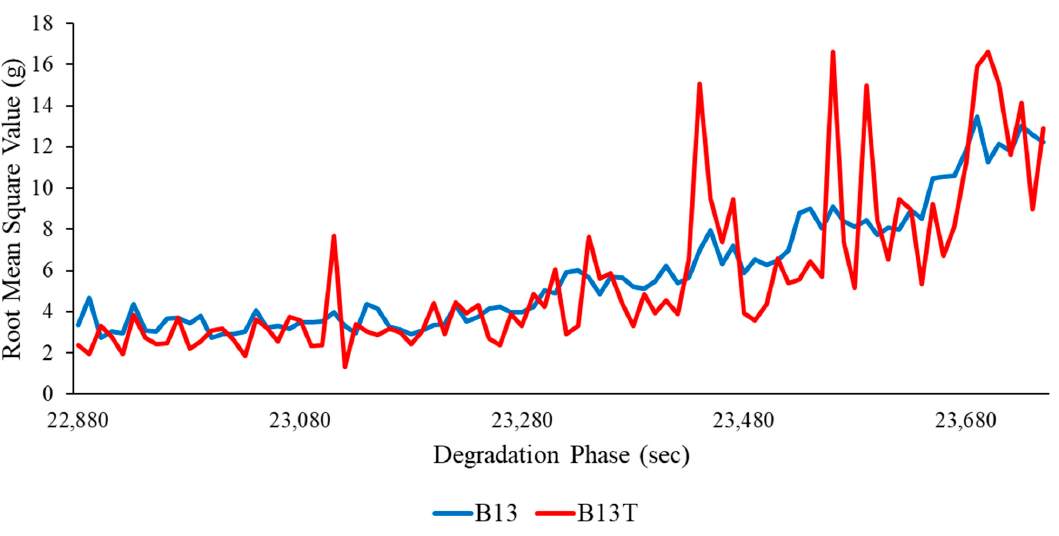
Figure 8. Real vs. artificial root mean square values for B13. Table 3. Statistical comparison of real features and generated features.